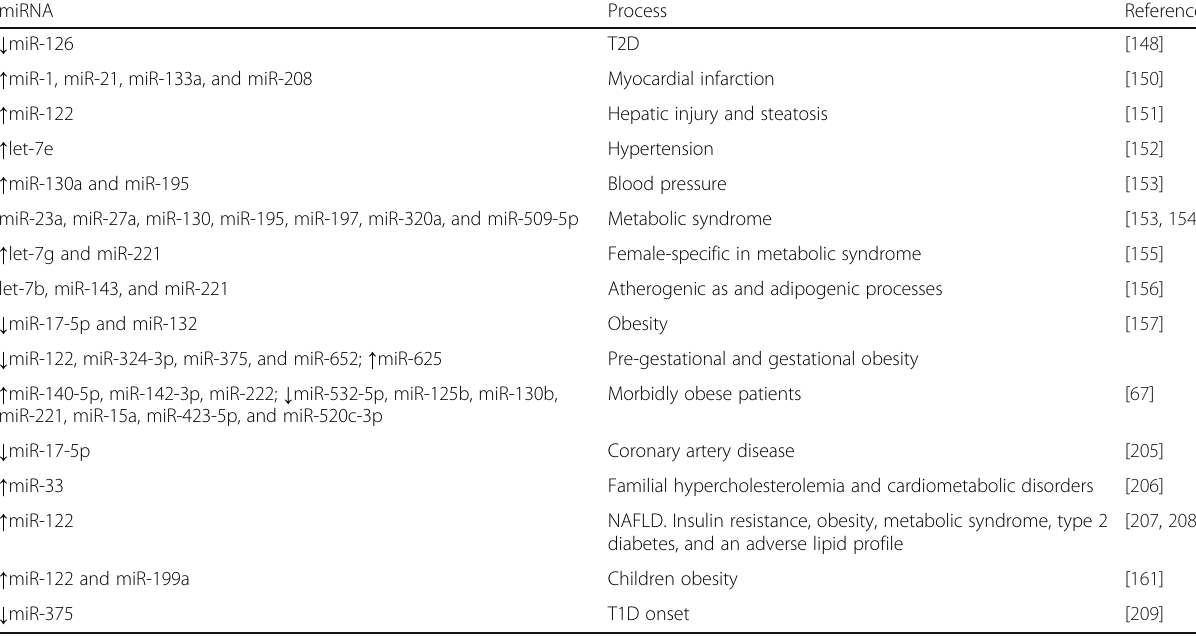
Table 4 Summary of the current knowledge on circulating miRNAs in the context of obesity and metabolic diseases